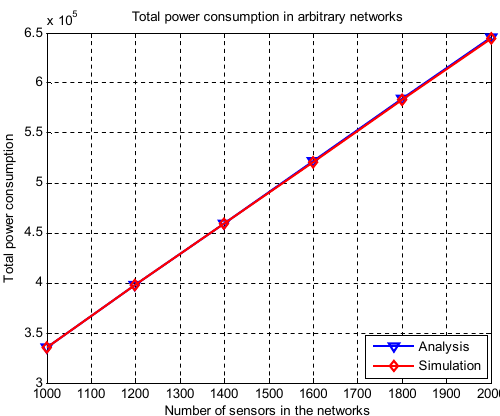
Figure 8. Total power consumption in random networks with different number of sensors, transmission range R = 8 when the BS at the center of the sensing area